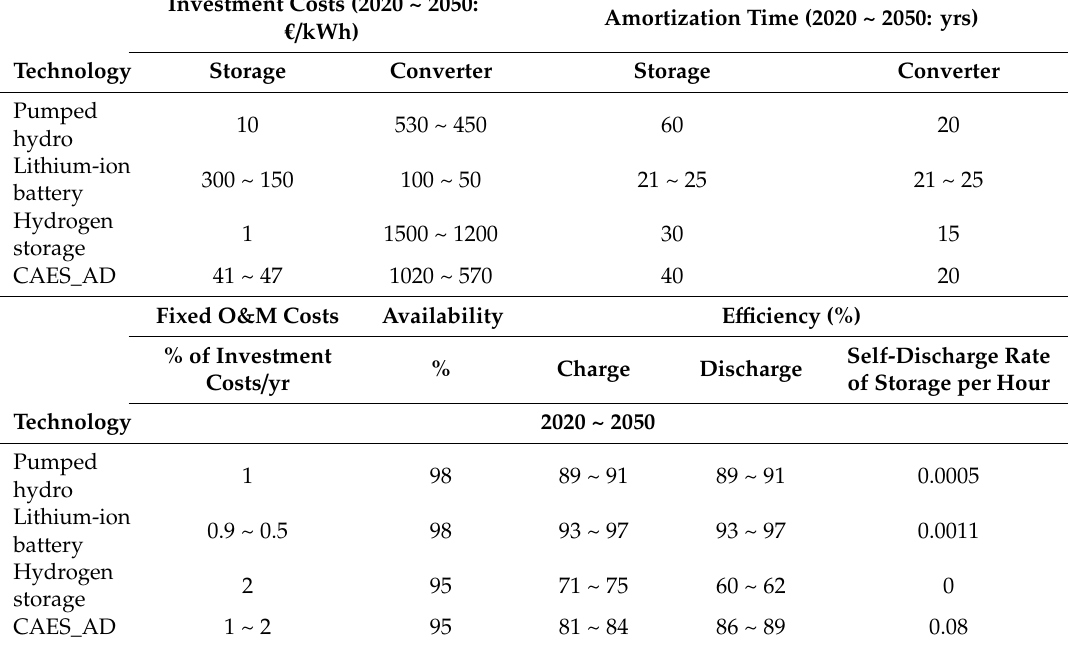
Table 2. Assumed economic and technological parameters for electric energy storage [35].